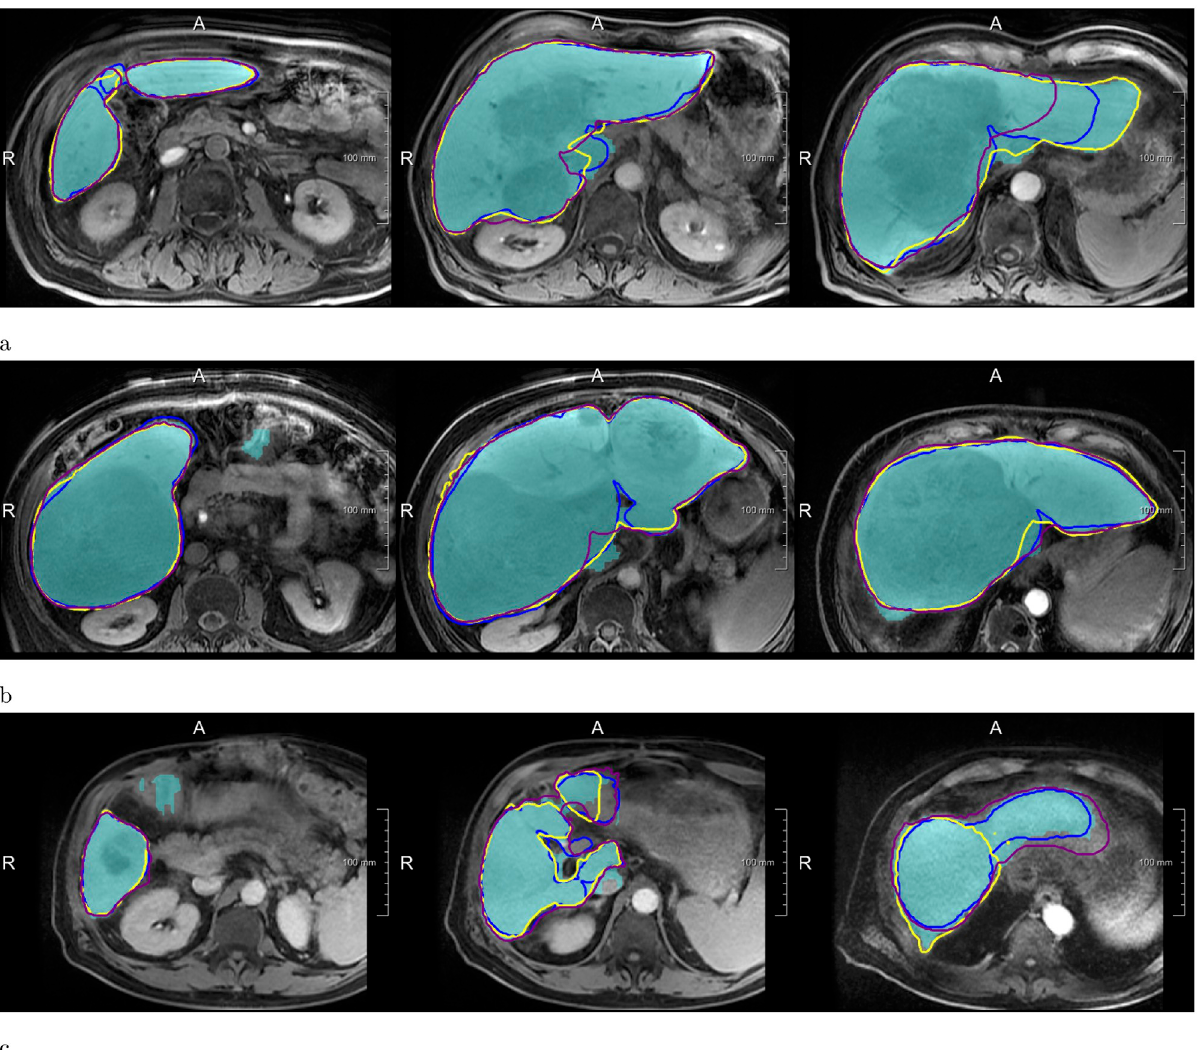
Fig 4. Examples of segmentations produced by the Liver-Net (cyan) compared to three routine delineations by Rad (blue), Res1 (yellow) and Res2 (purple). (a) Case where Liver-Net was more consistent with the reference than the routine segmentations: 0.70% (0.96), 8.89% (0.94), 6.56% (0.95) and 11.7% (0.92) for RVE (DICE) for the automatic method and the routine segmentations by Rad, Res1 and Res2, respectively. (b) Case where automatic and routine segmentations were very similar: 2.62% (0.97), 2.27% (0.97), 0.87% (0.97) and 0.09% (0.97). (c) Case where automatic liver mask had the biggest RVE: 8.49% (0.94), 2.24% (0.94), 0.80% (0.95) and 5.97% (0.94).